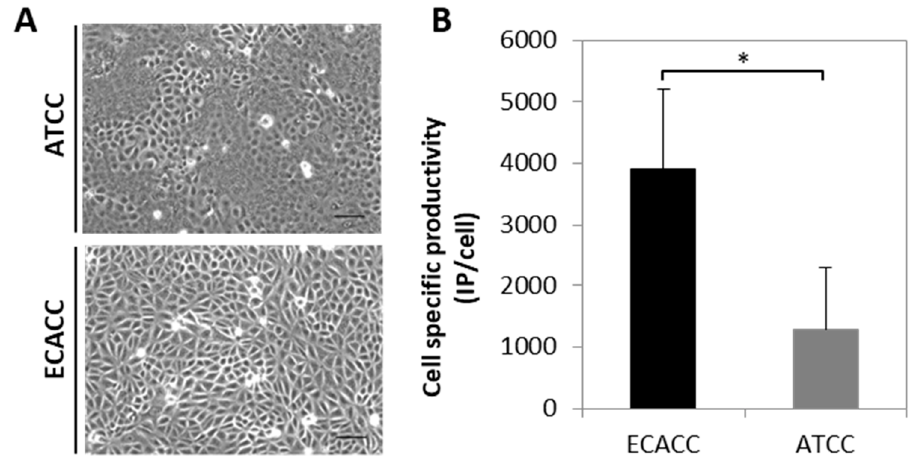
Figure 1. Morphology and canine adenoviral vectors type two (CAV-2) productivity of Madin–Darby canine kidney (MDCK) parental cells from American Type Culture Collection (ATCC) and European Collection of Authenticated Cell Cultures (ECACC). ( A ) Morphology of ATCC (upper panel) and ECACC (bottom panel) MDCK cells in confluent monolayer cultures. Cells were analyzed in the first passages (2 or 3) relative to the original vial received from each cell bank, using an inverted contrast phase microscope and digitally processed using the open source ImageJ software (http://imagej.nih.gov/ij/, 1997–2012). Scale bar: 100 μ m. ( B ). Cell specific productivity of CAV-2 with MDCK parental cells from ECACC and ATCC in serum-containing adherent cultures assessed at 40 h post infection. Infection was performed with CAV-2pIX-GFP virus at multiplicity of infection (MOI) 5 and infectious particles titer determined in DK-E1 cells as detailed in Materials and Methods. Values are shown as average ± standard deviation ( n = 4), * p < 0.05, given by Welch’s t -test.